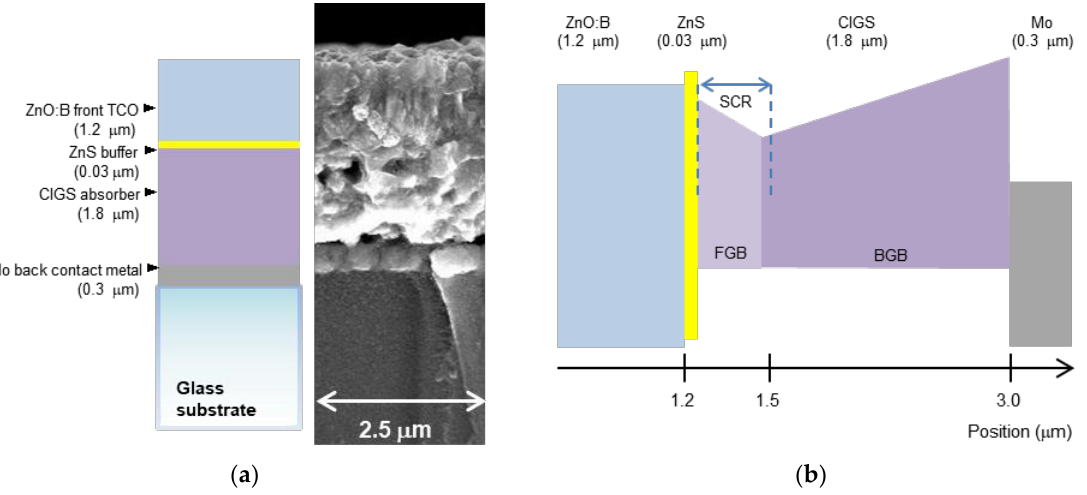
Figure 1. Device structure: ( a ) scanning electron microscope (SEM) image of fabricated CIGS solar cell, and ( b ) schematic band structure for TCAD simulation, where FGB, BGB, and SCR are front gradient bandgap region, back gradient bandgap region, and space charge region, respectively.